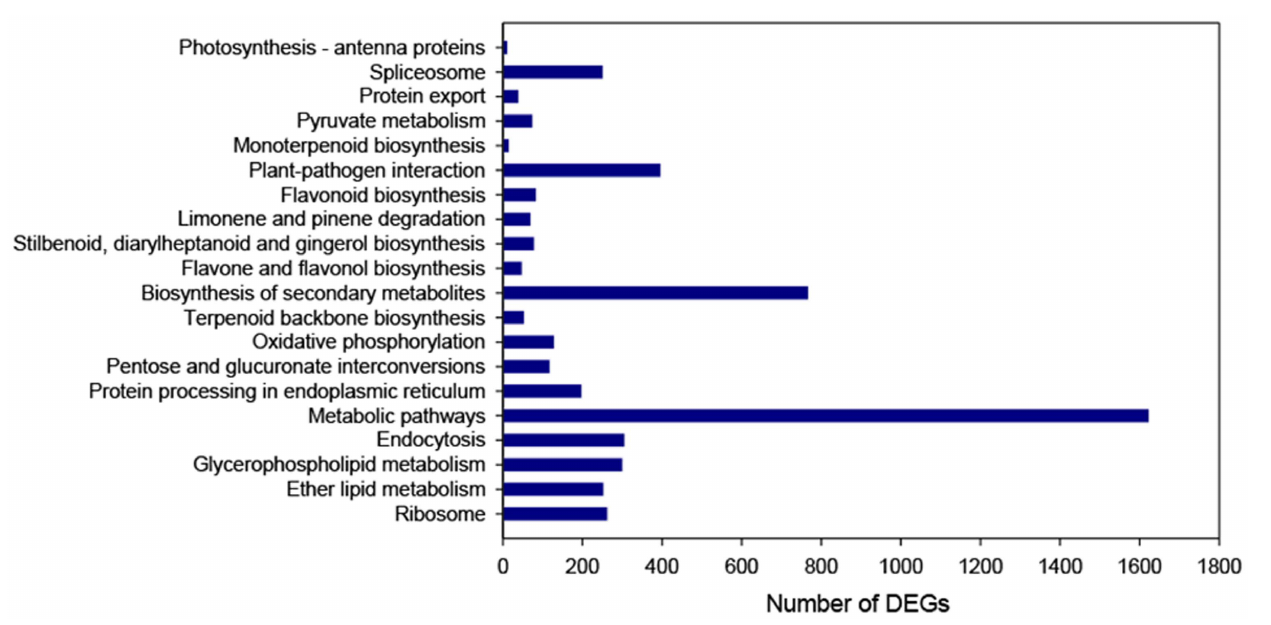
Figure 5. The top 20 pathway assignments of DEGs based on KEGG. The x-axis indicates the number of DEGs in a category. The y-axis from bottom to top shows the top 20